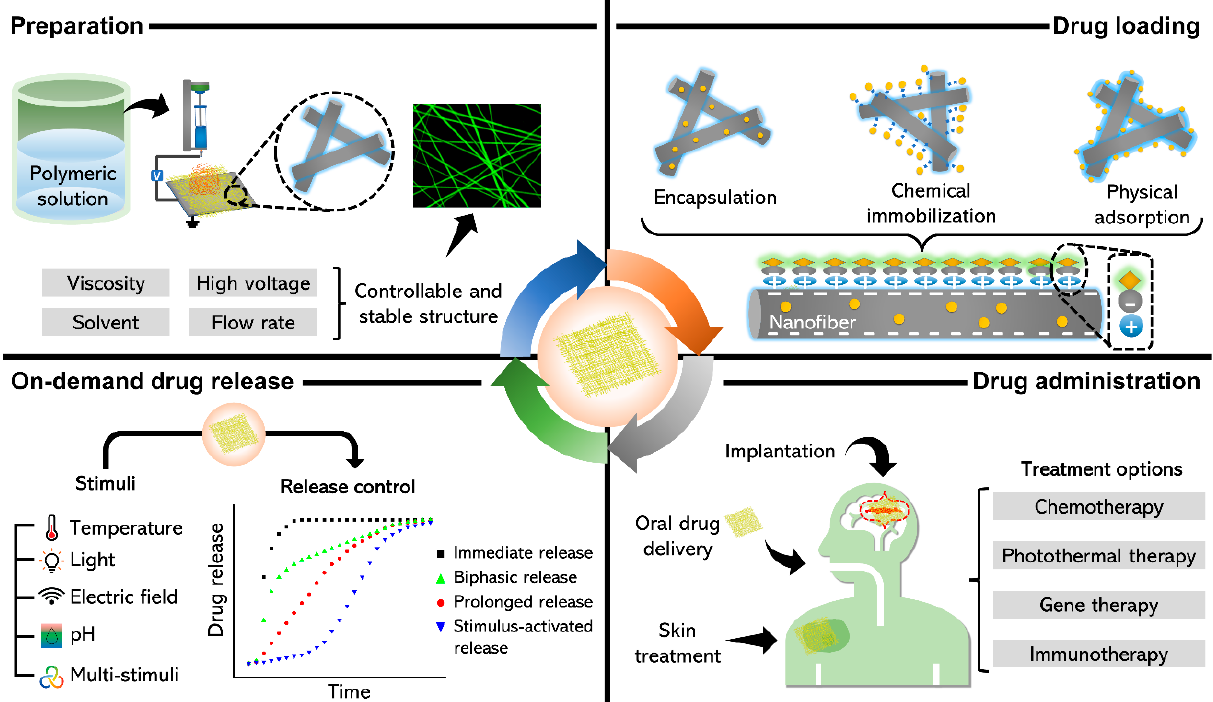
Figure 1. Schematic of on-demand drug delivery systems using stimuli-responsive NFs.